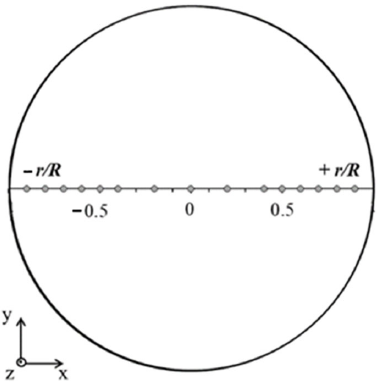
Figure 3. Measurement mesh and coordinate systems for the conductivity probe.